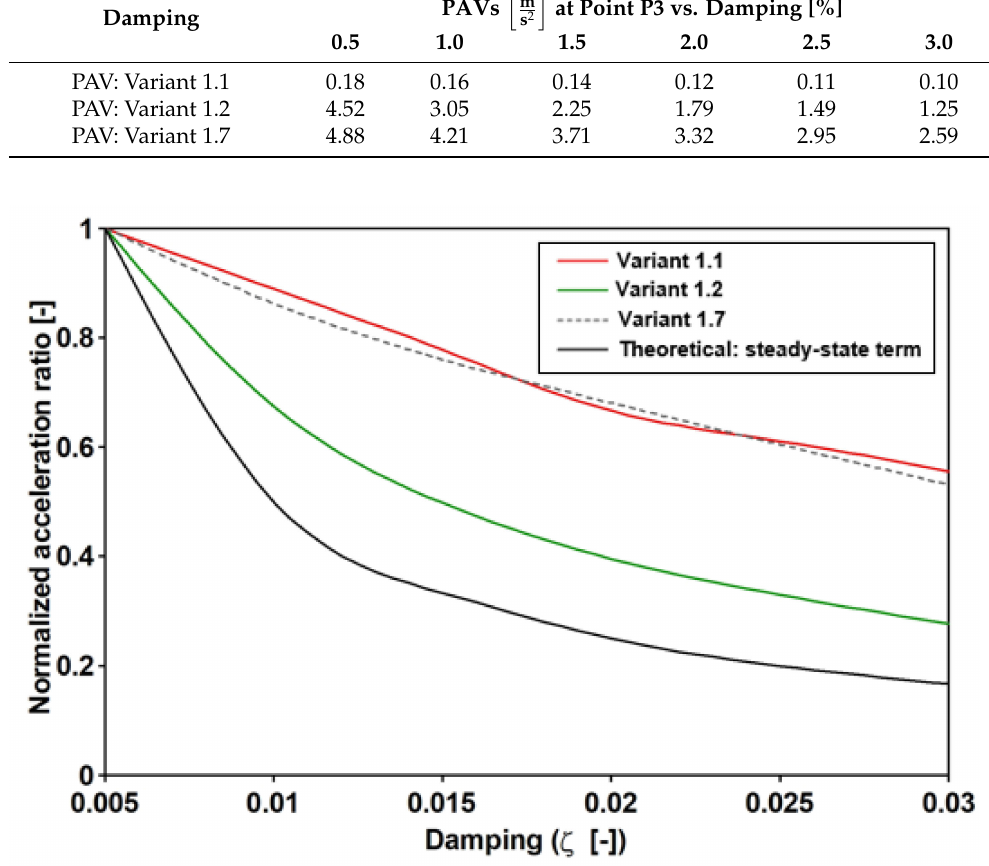
Table 15. Peak acceleration (PAV at the P3 station) vs. the frequency-independent damping ( ζ ). Damping